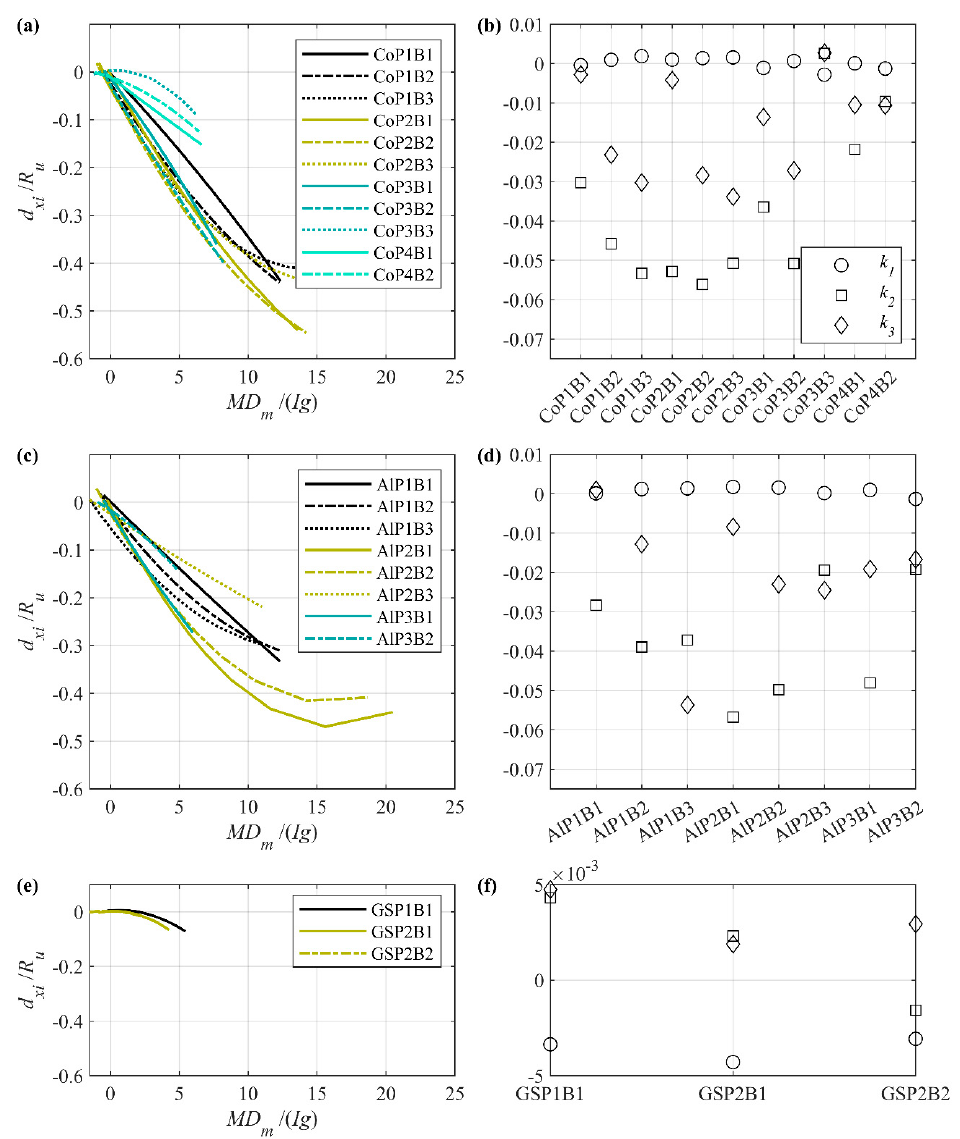
Figure 9. Backwash cross-shore distance travelled—moment relationship and coefficients. Lines correspond to Equation (24) fitted for each averaged event for objects with concrete ( a ) and aluminum ( c ) densities. Markers indicate the coefficients k 1 , k 2 , and k 3 , of Equation (24) ( e ) varying as a function of the scenario and for objects with concrete ( b ) and aluminum ( d ) ( f ) densities.